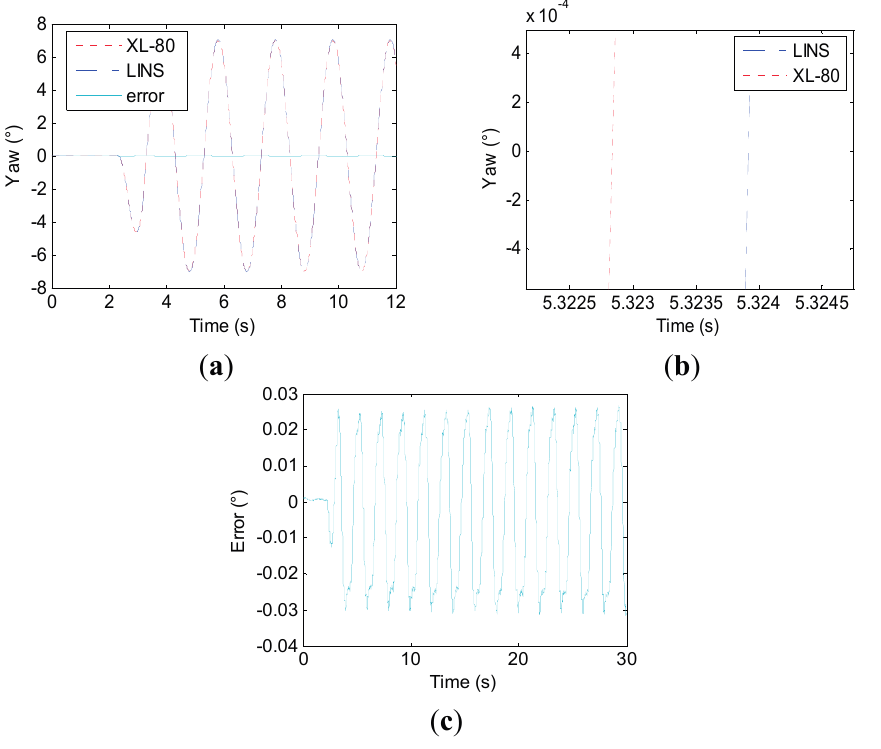
Figure 12. 5 t ms Δ = wobbling test results. ( a ) First 12 s wobbling test; ( b ) Phase relationship between table and LINS; ( c ) Error curve.